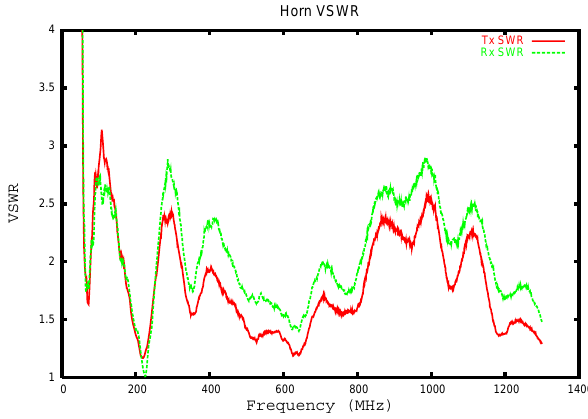
Fig. 1. Voltage Standing Wave Ratio (VSWR) for both transmitter (Tx) and receiver (Rx) horn used for data taken at South